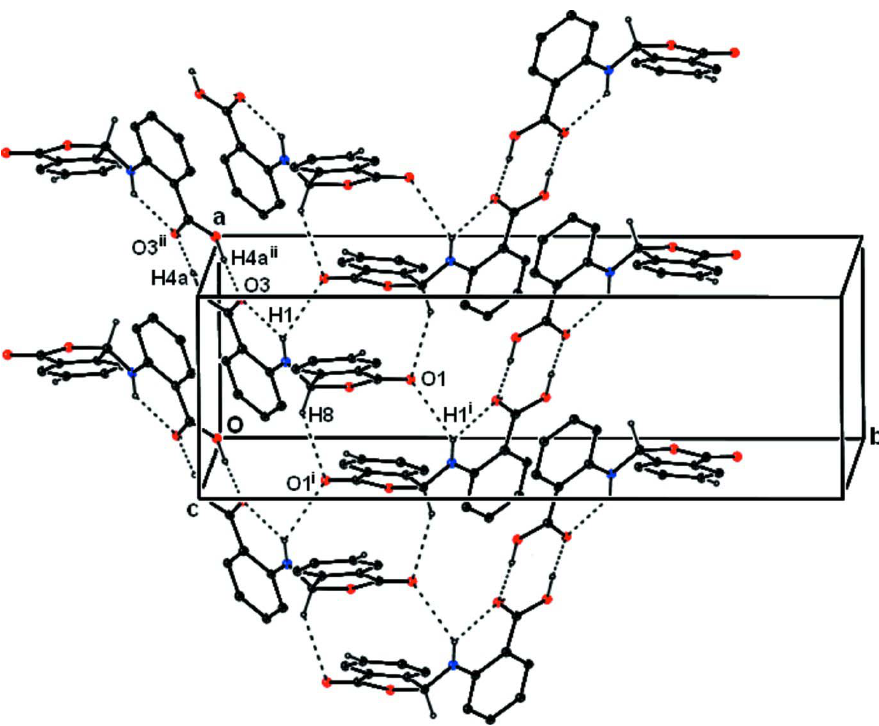
Figure 2 A partial packing diagram of (I), showing the formation of R 22 (8) and R 22 (11) ring motifs. Hydrogen bonds are shown as dashed lines [symmetry codes: (i) x, 1/2 - y, z - 1/2; (ii) 1 - x, -y, 2 - z]. H atoms not involved in hydrogen bondings have been omitted for